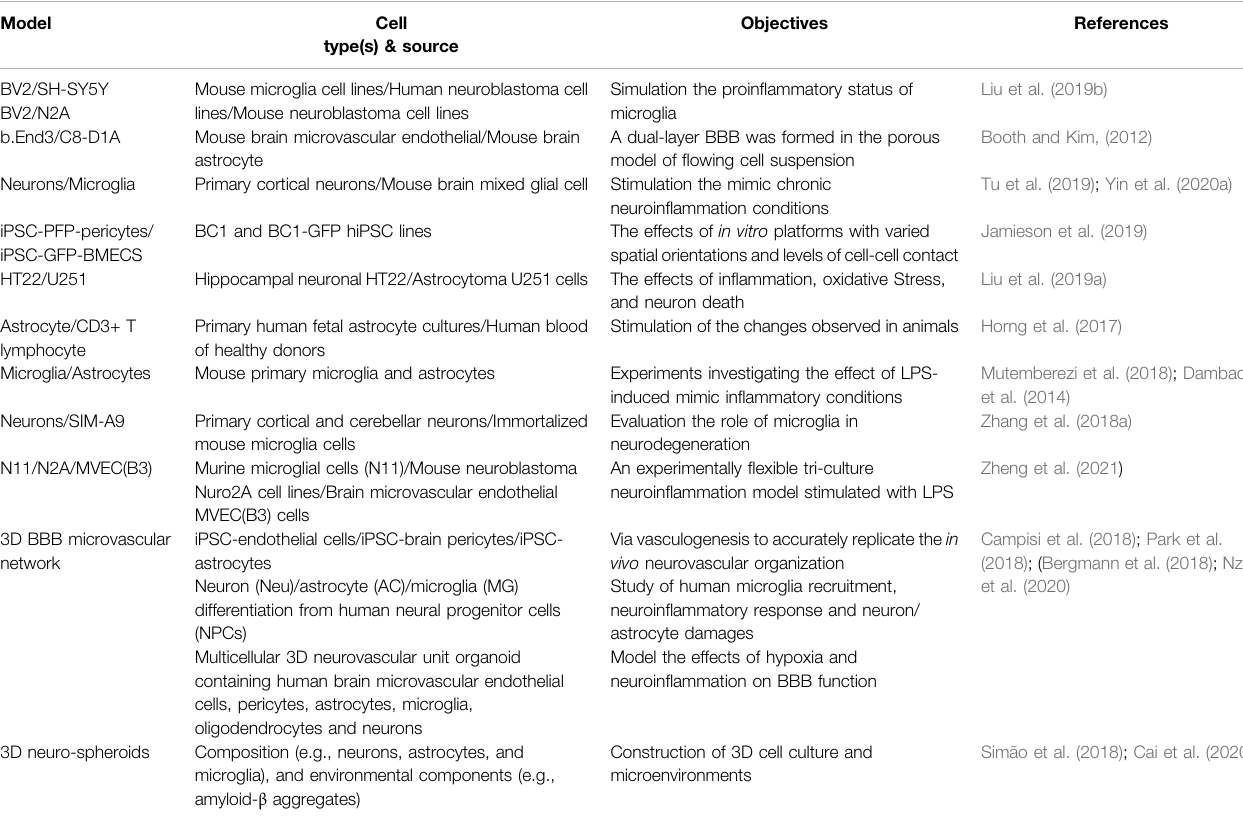
TABLE 1 | Brain in fl ammation 2D and 3D co-culture